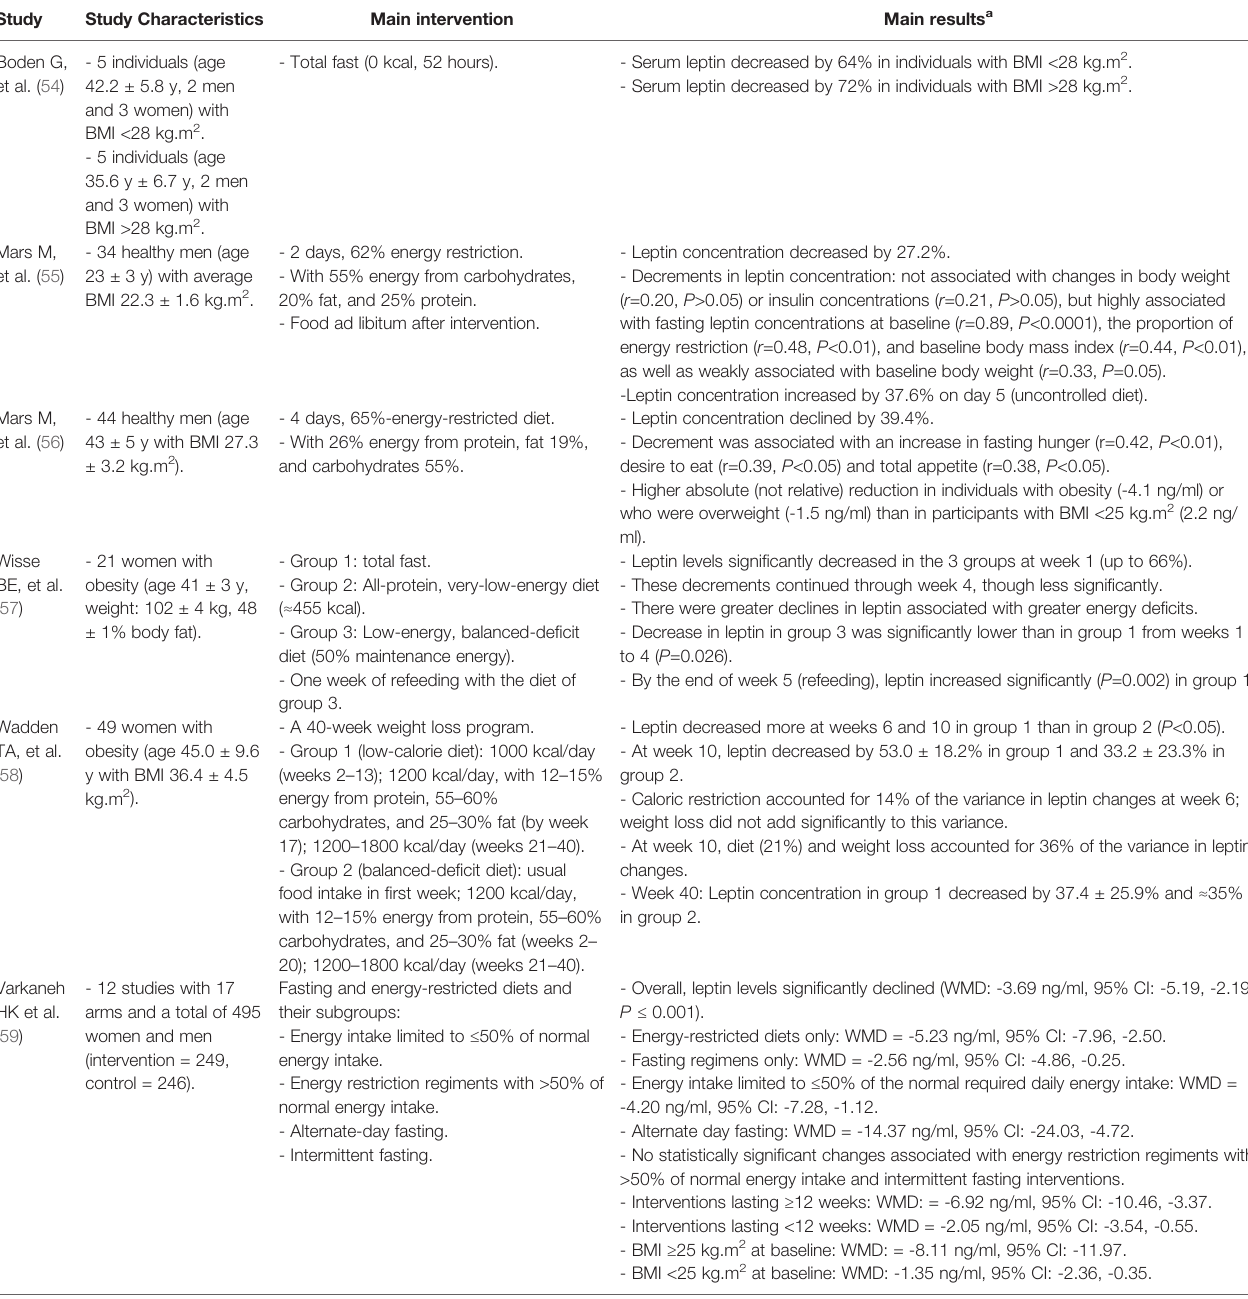
TABLE 2 | Summary of studies linking nutritional interventions to decrements in leptin